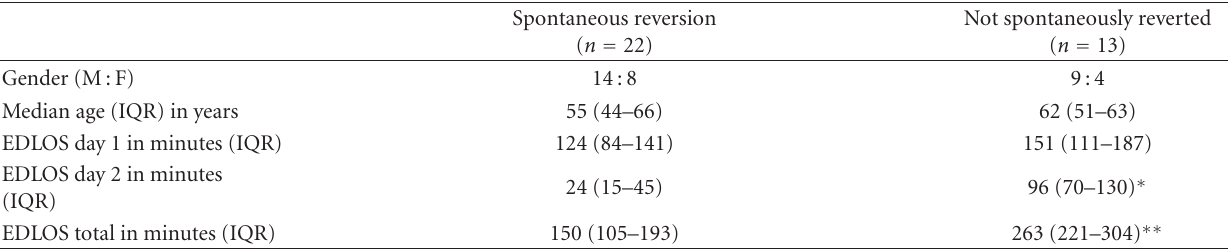
Table 2: Demographics & ED Length of